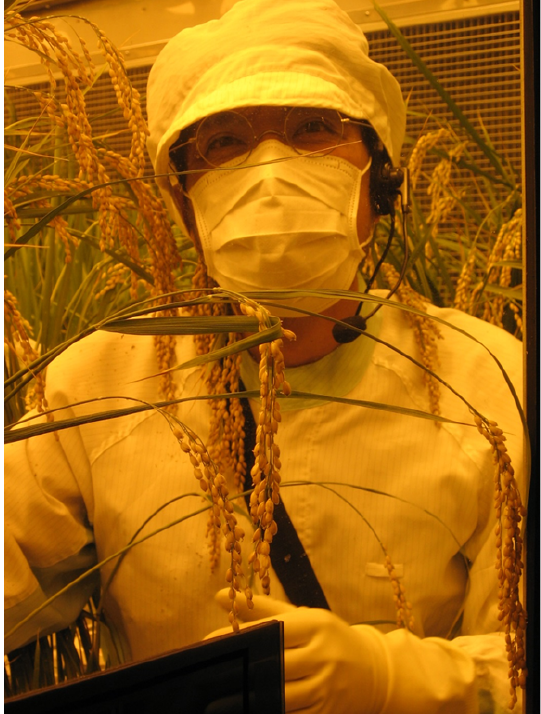
Figure 6. “Econaut” crew member of the Closed Ecological Expe- riment Facility (CEEF) team in Japan tending rice plants inside the facility (2007). Two Econauts and two miniature goats lived inside the facility for periods of up to 4 weeks, where full life support, including a near-complete diet was provided by plants. Notice the yellowish orange light from the high pressure sodium lamps used for crop light (photo taken by the